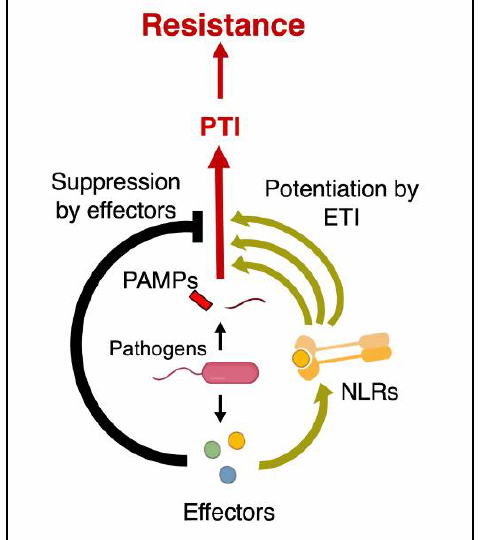
Figure 3. Schematic representation of the ‘Circular Model’ of plant–pathogen interaction. (This figure was originally drawn by Prof. Jonathan Jones, Sainsbury Lab, Norwich, UK, and it is being produced here with his permission).